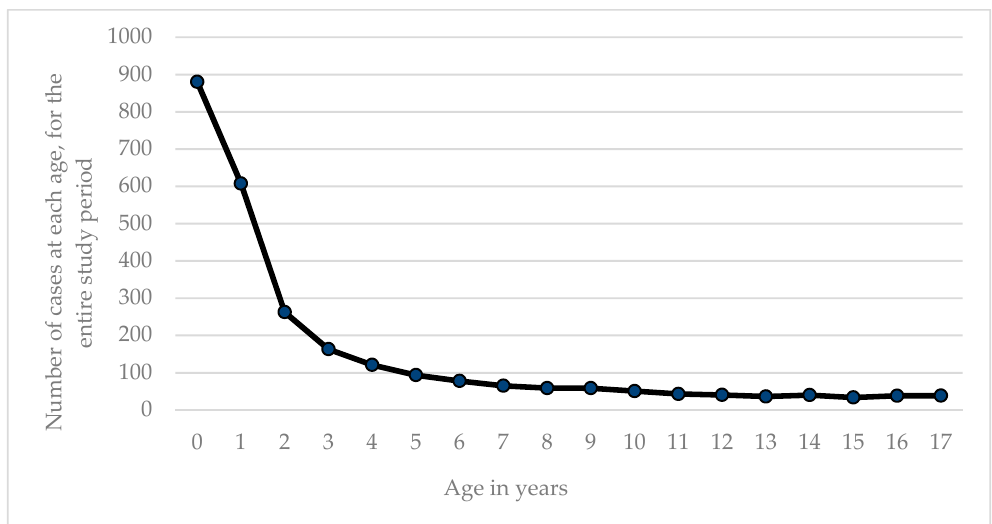
Figure 3. of NTS salmonellosis in Queensland over the period 1997–2015 by age in years from Salmonellosis notification and ABS population data.